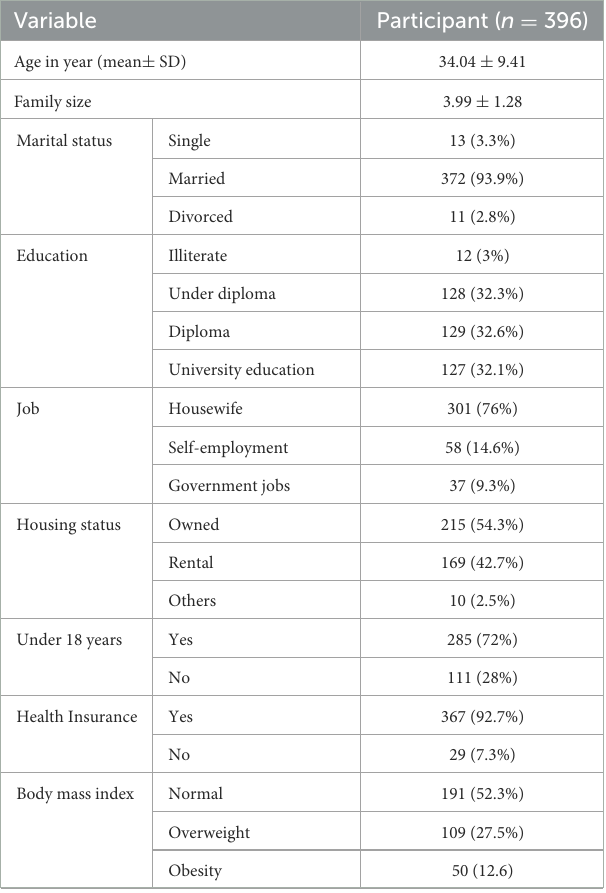
TABLE 1 Socio-demographic information of the participants.